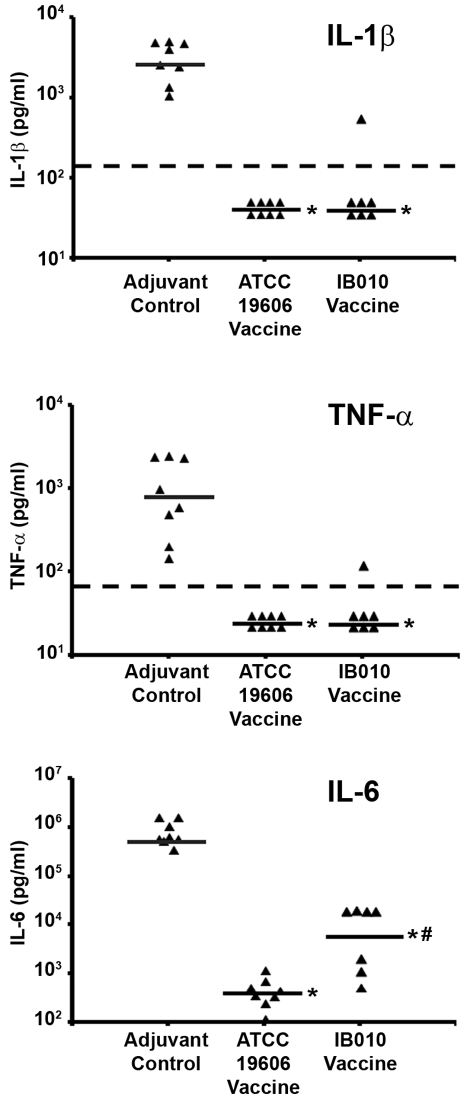
Figure 4. Effect of vaccination on post-infection pro-inflammatory cytokine levels. Immunized and control mice were infected with 2.0 6 10 6 cfu (300 6 LD 50 ) of the ATCC 19606 strain and serum levels of IL- 1 b , TNF- a , and IL-6 were determined (n 5 8 mice/group). Data points represent cytokine levels from individual mice, and horizontal lines represent median values from groups of mice. * p , 0.05 compared to control mice, # p , 0.05 compared to ATCC 19606 vaccinated